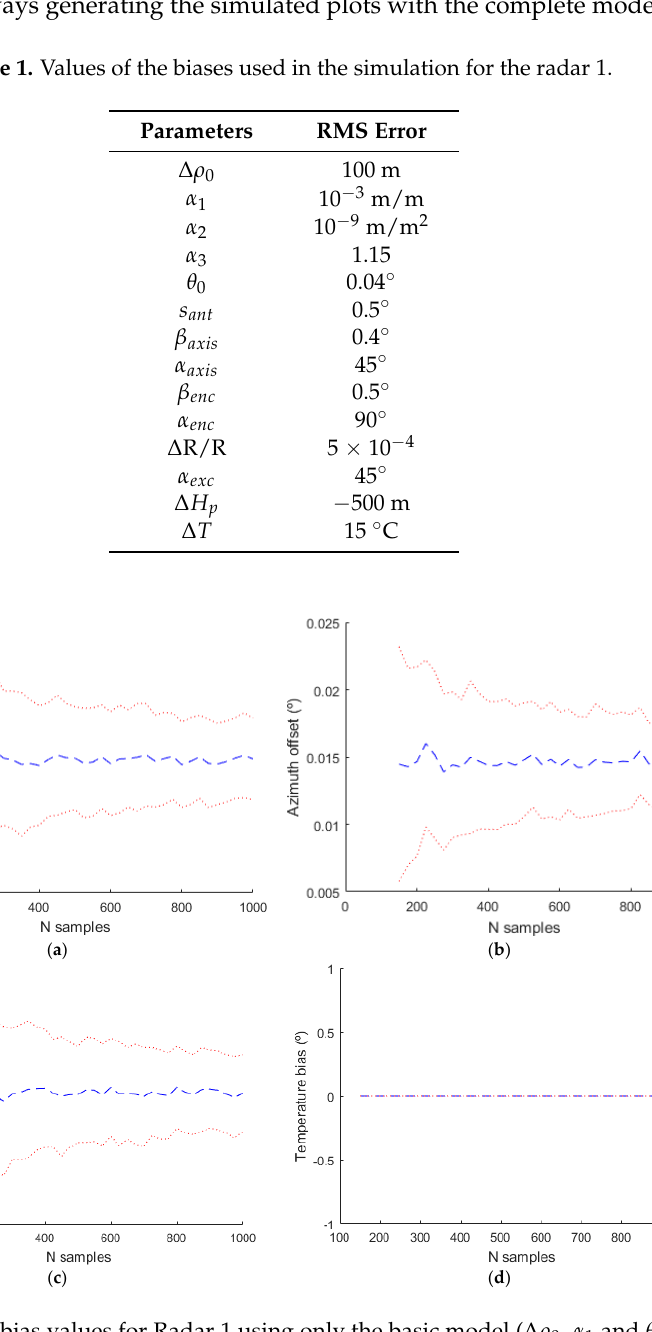
Figure 12. Estimated bias values for Radar 1 using only the basic model ( ∆ ρ 0 , α 1 and θ 0 ). ( a ) Range offset; ( b ) Azimuth offset; ( c ) Range gain; ( d ) Temperature